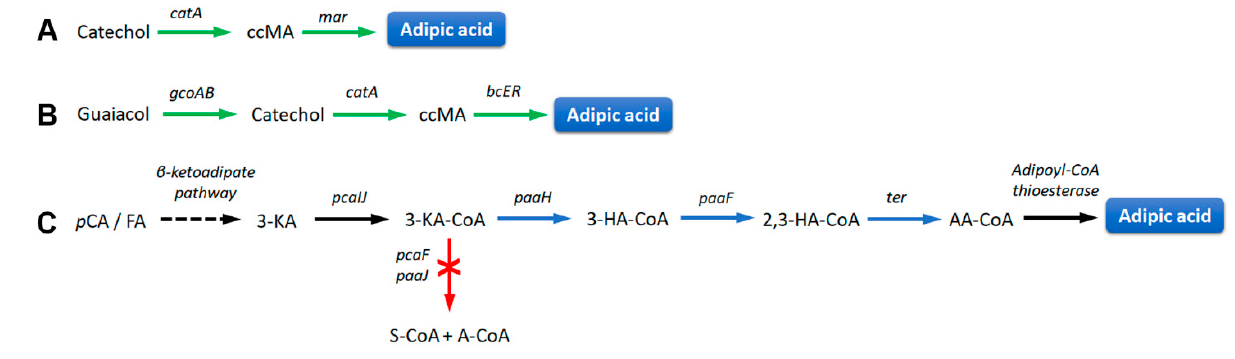
Figure 6. Scheme of adipic acid production from engineered ( A ) E. coli Δ iscR [115], ( B ) E. coli RARE [114] and ( C ) P. putida KT2440 [116]. Encoding genes: catA, catechol 1,2-dioxygenase ; mar, muconic acid reductase ; gcoAB, cytochrome P450 GcoAB; bcER, enoate reductase ; paaH , 3-ketoadipoyl-CoA reductase; paaF , 3-hydroxyadipoyl-CoA dehydratase; ter , 2,3-dehydroadipoyl-CoA reductase; pCA , p- coumaric acid ; 3-KA , 3-ketoadipic acid ; 3-KA-CoA, 3-ketoadipoyl-CoA ; 3-HA-CoA , 3-hydroxyadipoyl-CoA ; 2,3-HA-CoA , 2,3-dehydroadipoyl-CoA ; AA-CoA , adipoyl-CoA ; S-CoA , succinyl-CoA ; A-CoA , acetyl-CoA . Black arrows show the endogenous pathway; green arrows show overexpressed pathways; blue arrows show chromosomal inserted pathways; red crossed arrows identify deleted pathways; dashed arrows show additional multi-step pathways. Table 4. Metabolic engineering strategies for the production of bio-based plastics and pharmaceuticals